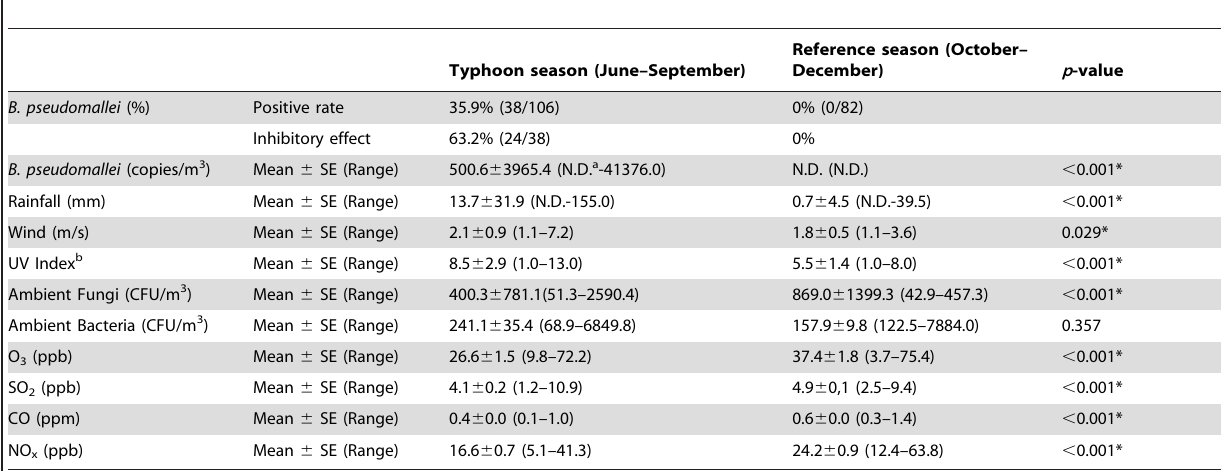
Table 2. Descriptive statistics for ambient B. pseudomallei and environmental factors during the typhoon season (June to September) and the reference season (October to December) near Lotus Pond in South Taiwan.